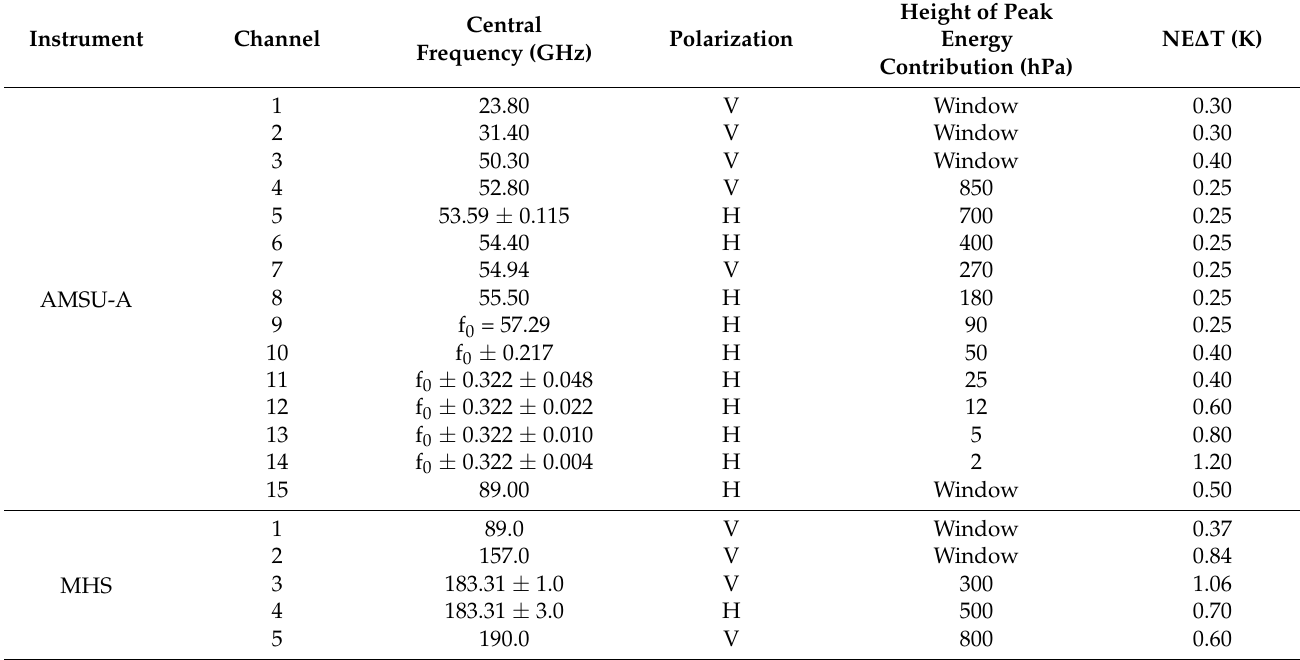
Table 2. NOAA-19 AMSU-A and MHS channel